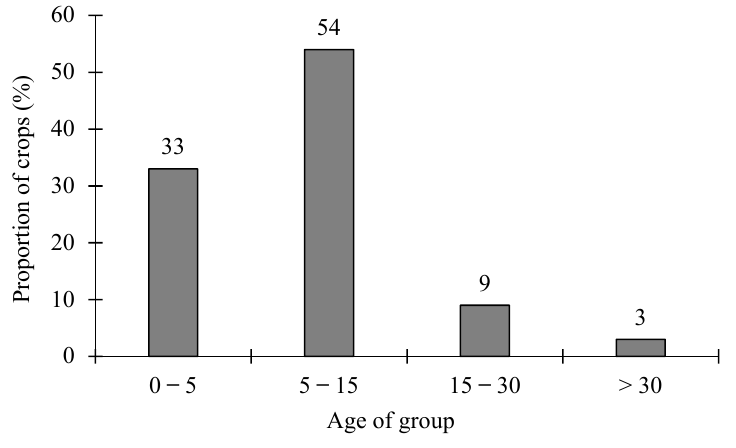
Figure 13. Age of cocoa farms in Biankouma region.